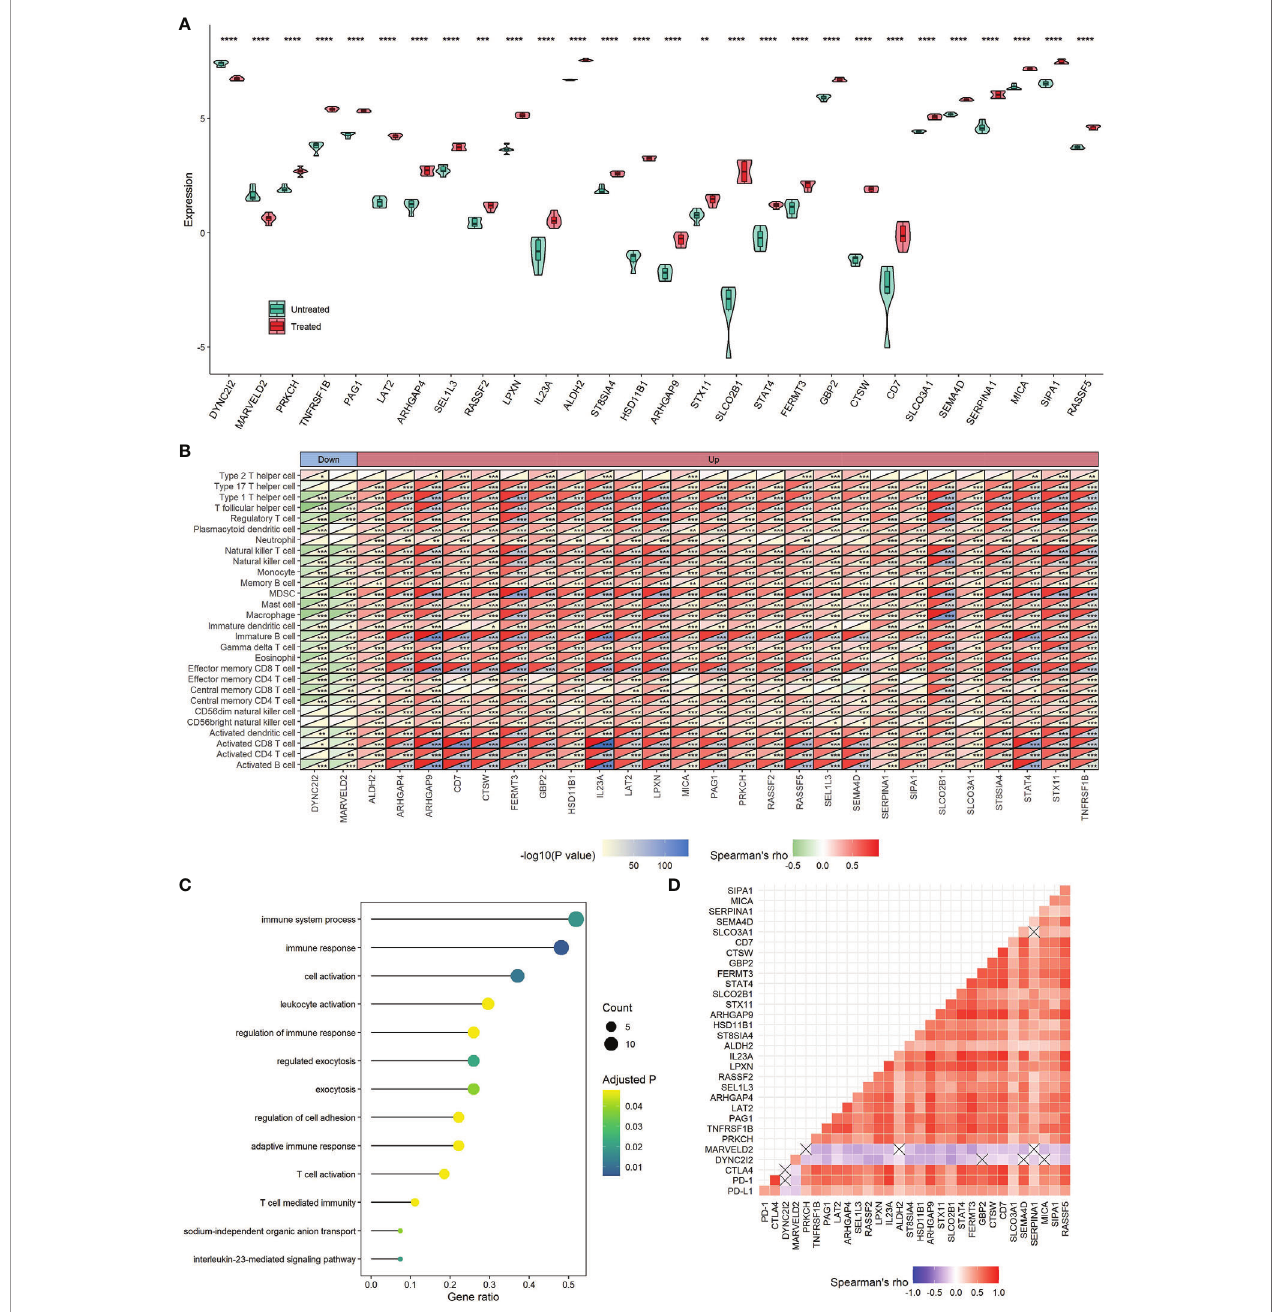
FIGURE 10 | Roles of 28 TME-relevant genes perturbed by CKI. (A) Differential expression of 28 TME-relevant genes between CKI-treated and control groups. The P values were generated by the DESeq2 method. (B) Associations between the expression of 28 TME-relevant genes and the relative abundance of 28 tumor-in fi ltrating immune cells using Spearman ’ s correlation based on the METABRIC cohort (*0.01 < P < 0.05; **0.001 < P < 0.01; ***0.0001 < P < 0.001; **** P < 0.0001; ns, P > 0.05). (C) GO enrichment analysis for 28 TME-relevant genes. A total of 13 signi fi cant biological processes with adjusted P < 0.05 are shown. (D) Correlations of the expression of 28 TME-related genes using Spearman analysis based on the METABRIC cohort. PD-L1, PD-1 and CTLA4 were also plotted. Negative correlation is marked with blue and positive correlation with red. “ × ” means the corresponding correlation coef fi cient is regarded as insigni fi cant ( P >